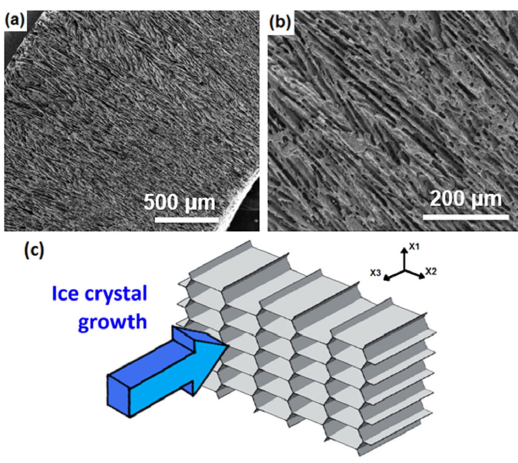
Figure 1. (a and b) Representative SEM micrographs showing the radially aligned macroporosity in freeze-cast substrates produced from alumina suspensions with 15% solid loading and sintered at 1400 °C. (Reproduced from 17 under Creative Commons Licence). (c) Schematic representation of a honeycomb structure. The pore geometry can be compared to the lamellar and elongated pores obtained in freeze-cast materials from water-based